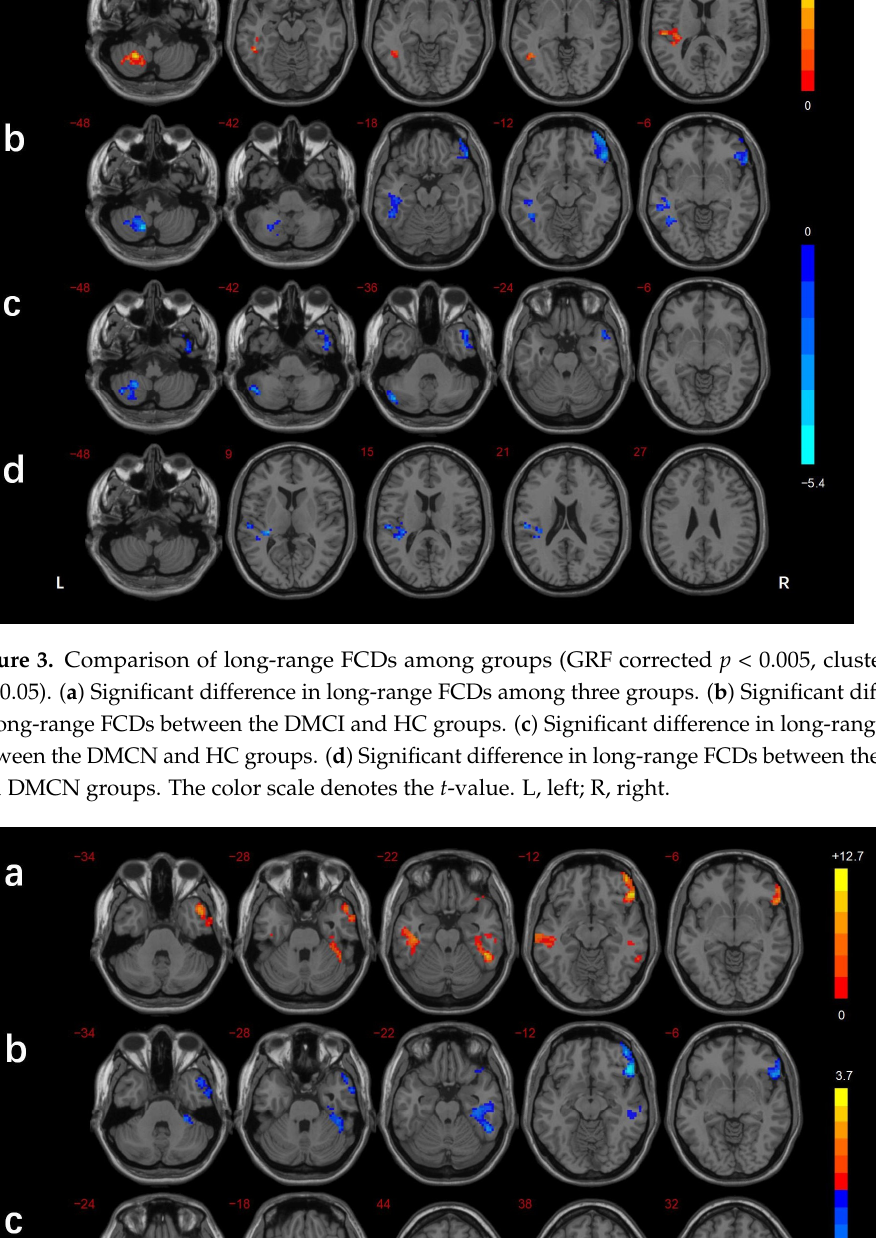
Figure 5. The correlations between RAVLT scores and long-range FCD in the left superior temporal gyrus. ( a ) Correlation between Z-scores of FCDs in the left superior temporal gyrus and the RAVLT immediate scores ( r = 0.356, p = 0.005); ( b ) Correlation between Z-scores of FCDs in the left superior temporal gyrus and the RAVLT delayed recall scores ( r = 0.335, p = 0.009). The asterisk (*) indicates coordinate values, controlling for effects of years of education.